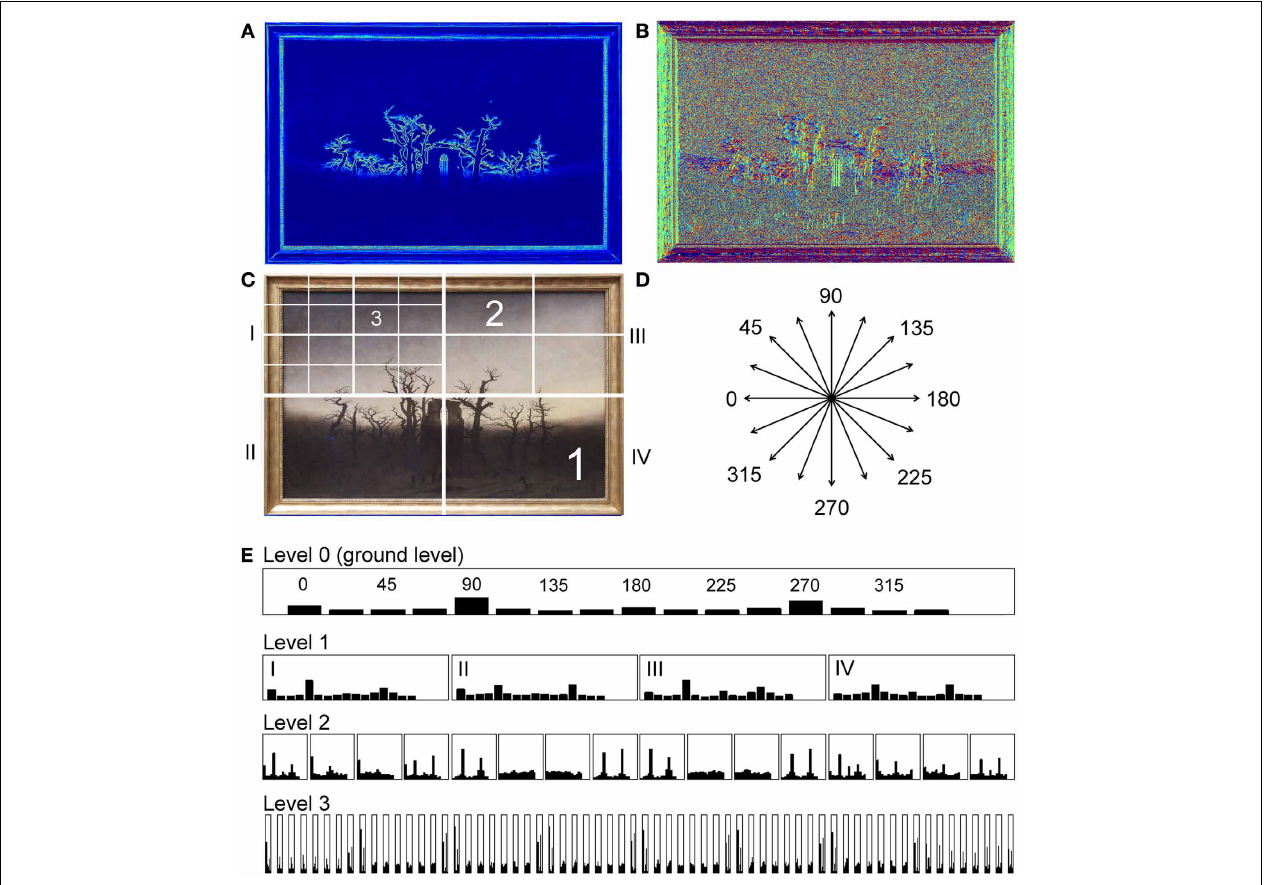
FIGURE 1 | Illustration of the image analysis. (A) Image of gradient strength for the painting shown in Figure 3B . Gradient strength is represented by rainbow pseudo-color coding. (B) Image of gradient orientation represented by different colors (e.g., red for horizontal orientations and green for vertical orientations). (C) Diagram of the section sizes at the different levels (1–3) of the PHOG analysis. There are four sections at level 1, 16 sections at level 2, and 64 sections at level